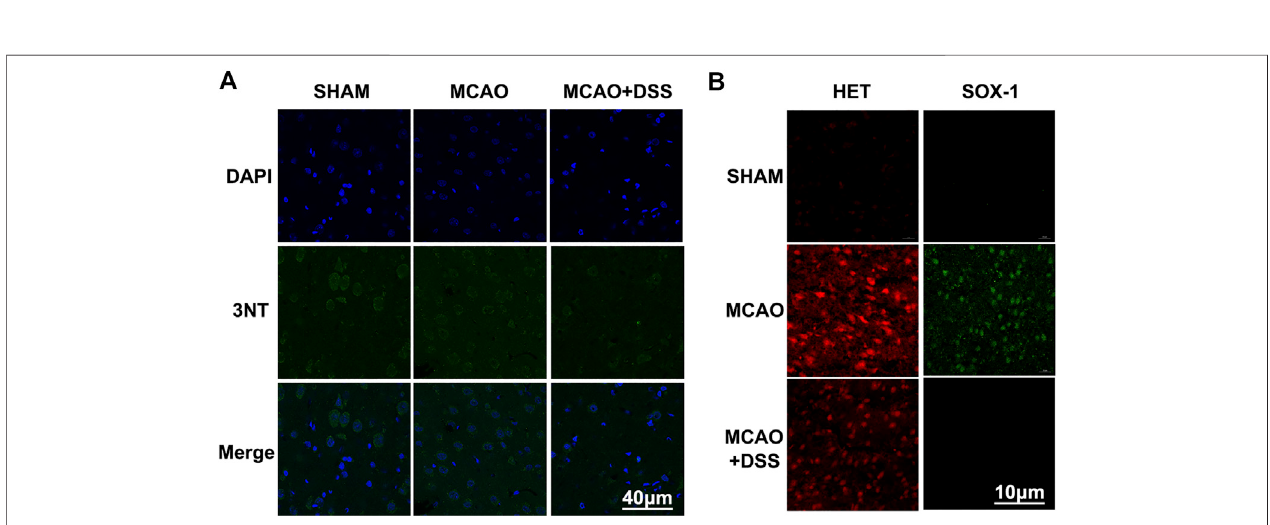
FIGURE3| DSSethanolextractdecreasedsuperoxideandperoxynitriteinischemic-reperfusedratbrains.DSSethanolextractwassimplynamedasDSS.Sham: sham control group; MCAO: MCAO ischemia-reperfusion group; MCAO + DSS: MCAO plus DSS ethanol extract treatment. Th rats were subjected to 2 h of MCAO ischemiaplus22 hofreperfusion.TheDSSethanolextractatthedosageof12 g/kgwasorallyadministratedintotheratsat30 minbeforereperfusionafter1.5 hMCAO ischemia. ( A) Representative immuno fl uorescent imaging of 3-nitrotyrosine (3-NT) (green), n (cid:2) 4. ( B) Representative immuno fl uorescent imaging of HKSOX-1 (green) and HEt (red) for detecting superoxide, n (cid:2) 4.